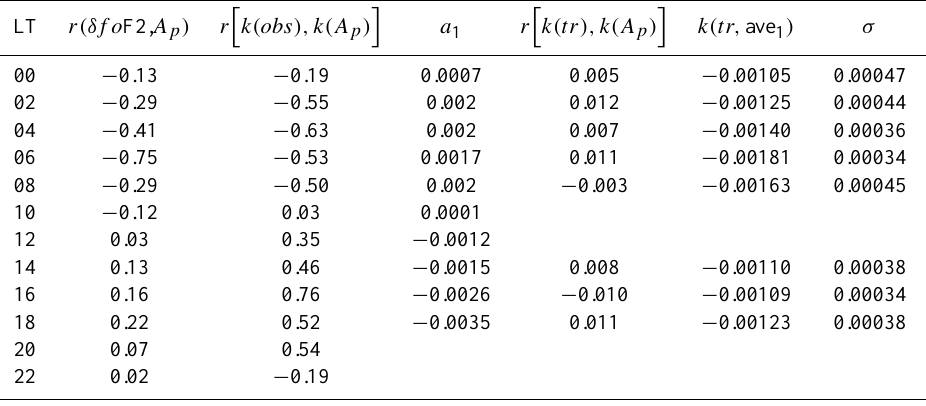
Table 8. Determination of the f o F2 trend for the Irkutsk